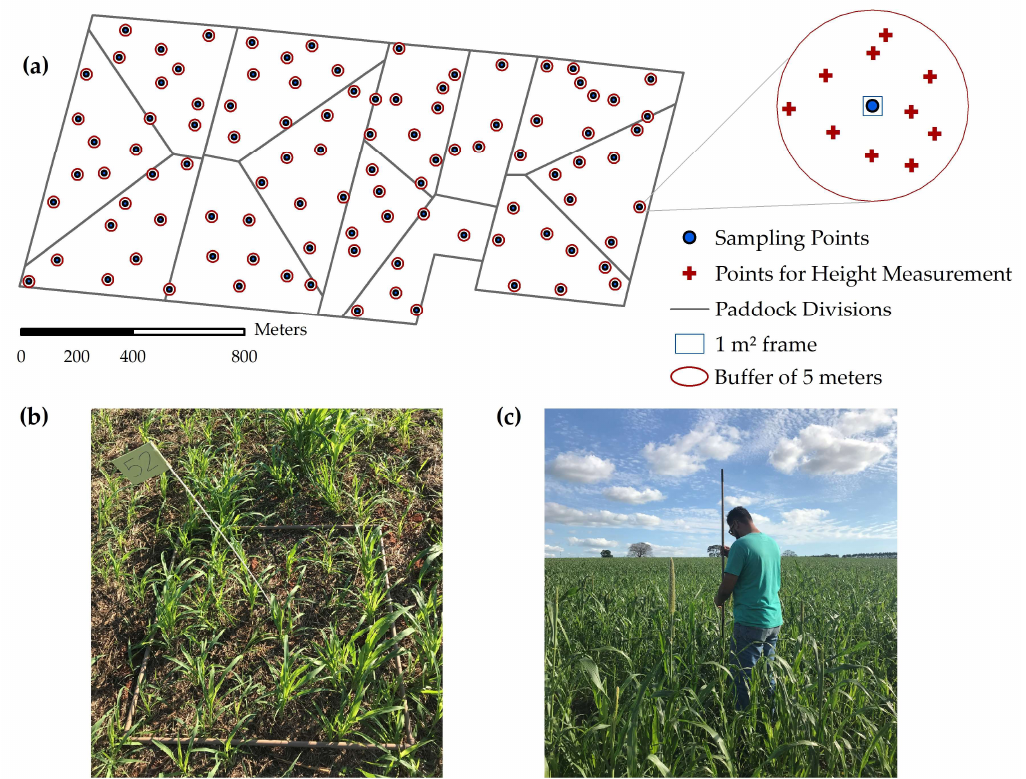
Figure 3. Spatial distribution of the sampling points within the study area using a stratified systematic unaligned sampling design ( a ) and field data collection: aboveground biomass (AGB) ( b ) and canopy height (CH) ( c ).